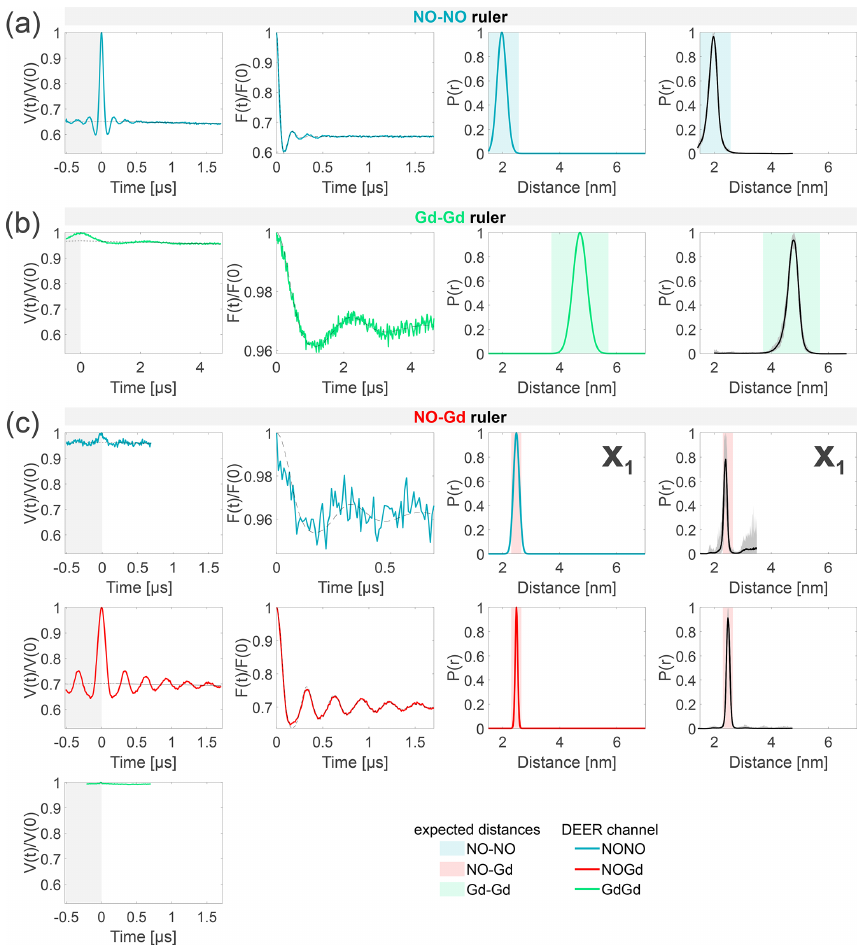
Figure 4. Characterization of the isolated rulers. The DEER setups are introduced in Fig. 3. The first column shows the primary data with background fit (gray areas are excluded from data evaluation). The second column shows the form factors (obtained by dividing the primary data by the background function) with the fit from the Gaussian fitting routine. The third column shows the obtained distance distributions. The fourth column shows the DEERNet analysis (generic network) done to provide an error estimation. A Tikhonov analysis of the data is shown in Fig. S4 (part B). An overview over of DEER data is given in Table S5 (part B). The time traces, form factors, and distance distributions recorded with the NONO DEER channel are colored in blue, those recorded with the GdGd channel are colored in green, and those recorded with the NOGd channel are colored in red. Regions in which distances can be expected based on the rulers present in the specific sample are represented as shaded blue, green, and red areas in the distance distributions. X 1 is a NO–Gd crosstalk in the NONO DEER